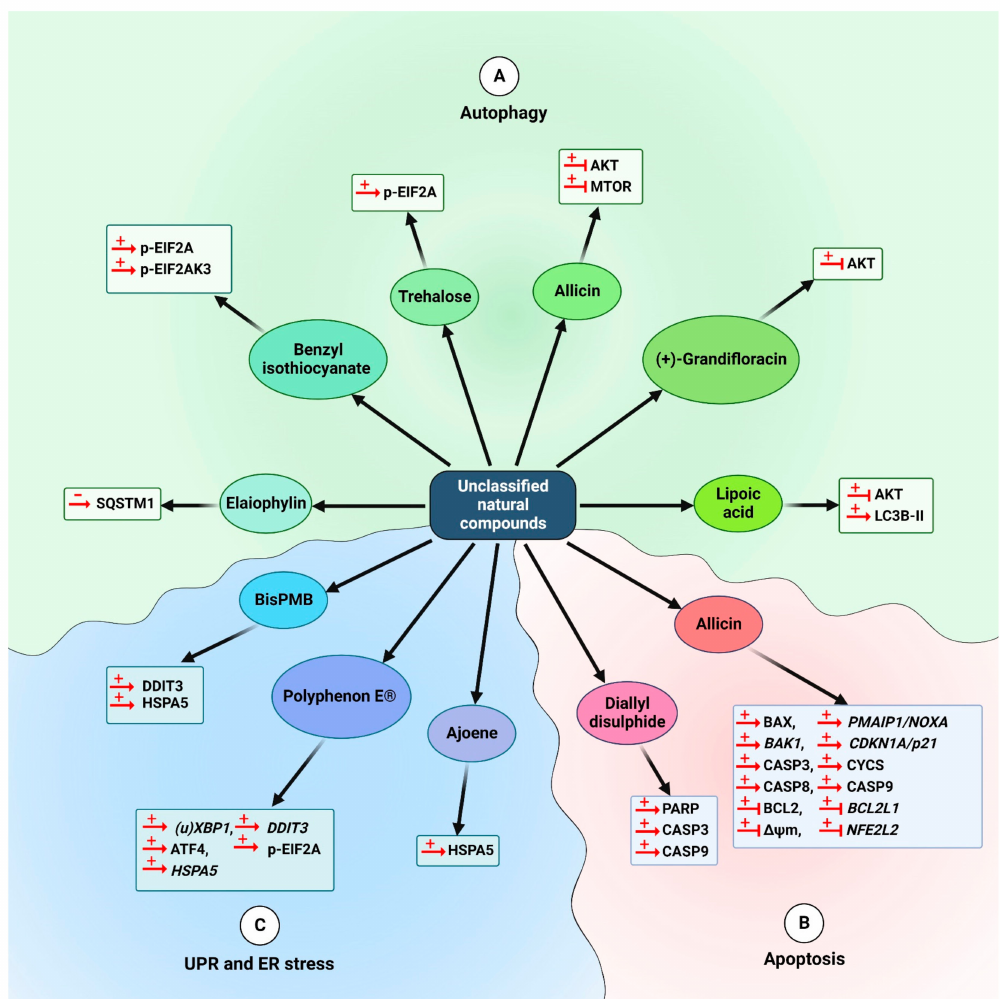
Figure 14. The schematic role of unclassified compounds on the proteins involved in three different pathways (( A ): Autophagy, ( B ): Apoptosis and ( C ): The UPR and ER stress). ( A ): Six natural com- pounds are shown in this part of the figure as autophagy modulators. Upregulation of p-EIF2A, p-EIF2AK3 and LC3B-II and inhibition of AKT and MTOR result in autophagy in cancer cells. Conversely, the accumulation of SQSTM1 showed that elaiophylin acts as an autophagy inhibitor. ( B ): Apoptosis: Two compounds that induce apoptosis are illustrated in this part. Both compounds cause PARP, CASP3 and CASP9 activation in different cell lines. Moreover, allicin induces apop- tosis via activation of CASP8 and upregulation of CDKN1A/p21 , PMAIP1/NOXA, BAK1, BAX and CYCS. Moreover, downregulation of NFE2L2, BCL2 and BCL2L1 and loss of ∆Ψ m are observed in allicin-treated cell lines. ( C ) UPR and ER stress: There are three compounds in this part that induce an ER accumulation of misfolded proteins and activate the UPR. Under ER stress induced by these compounds, some proteins, including p-EIF2A and ATF4, are overexpressed in different types of cancer cells. Moreover, the expression of some genes including HSPA5 , (u)XBP1 and DDIT3 is increased. → : Indicates activation or an increase in the mentioned protein expression. deactivation or a decrease in the mentioned protein expression. − and +: Indicate the effect of the proteins on different pathways ( − means negative effect and + means positive effect). The figure was created with BioRender.com. Licensing Right IP24OB76U3, 21 November